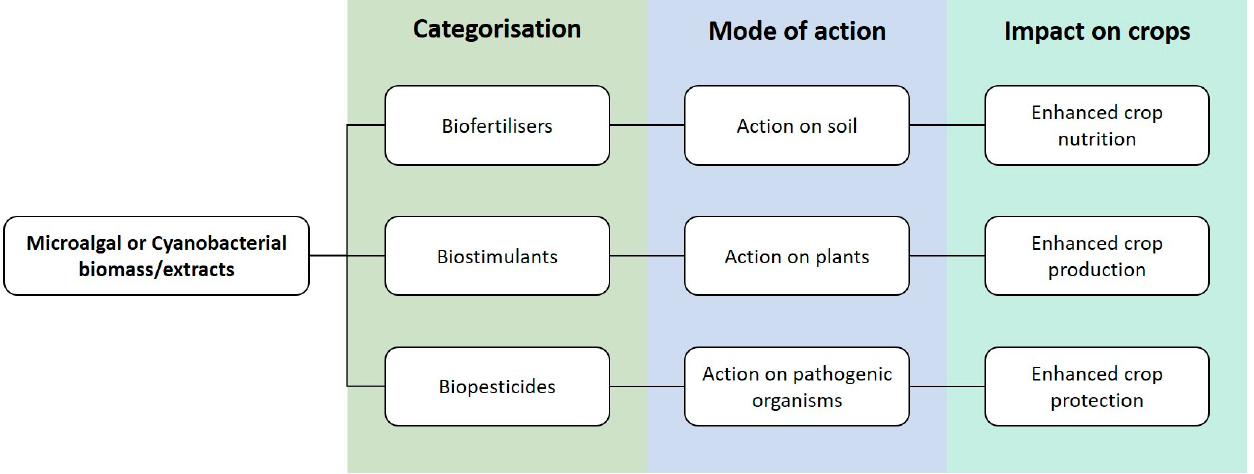
Figure 1. Categorisation of the main activities attributed to algal/cyanobacterial biomass and extracts in crops’